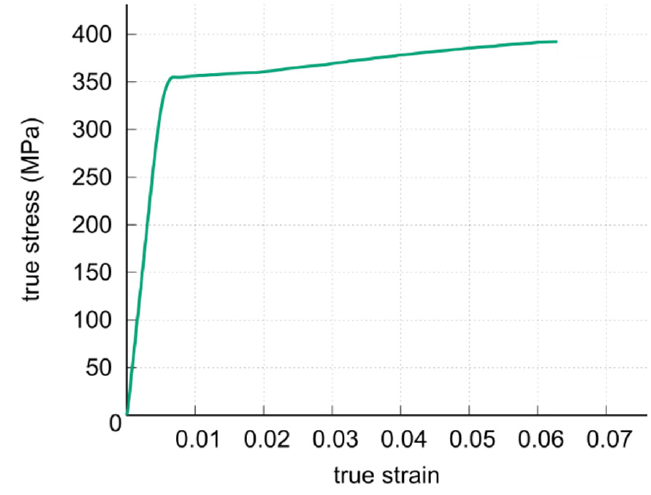
Figure 3. True stress-strain curve.